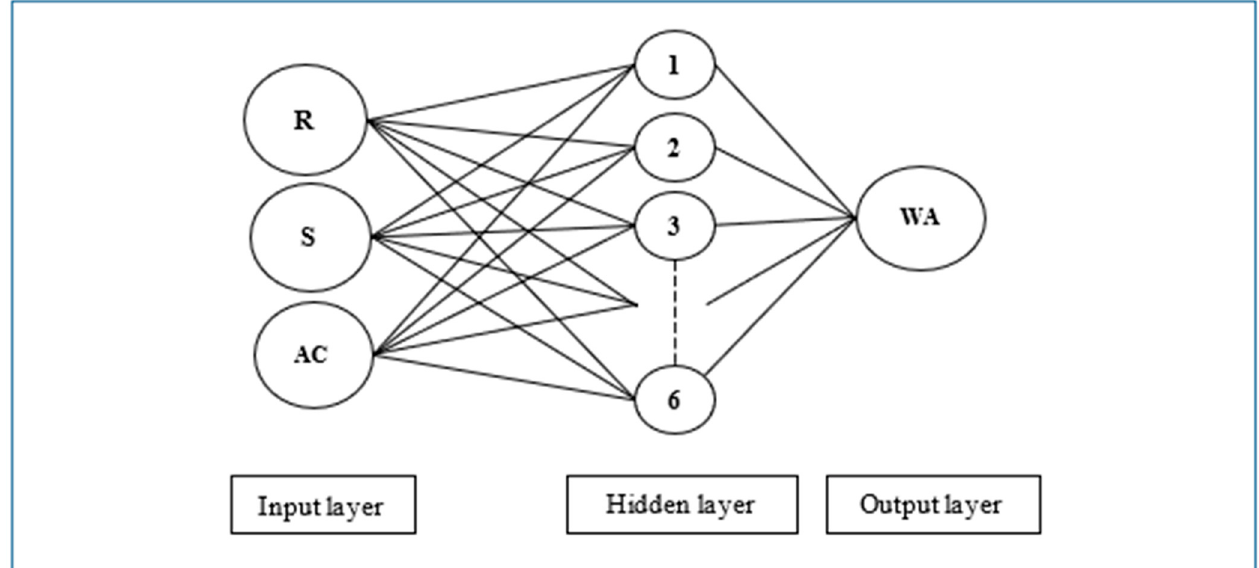
Figure 5. Artificial neuron network architecture for rotation-steel ball-Abrasion-Coefficient-water absorption.